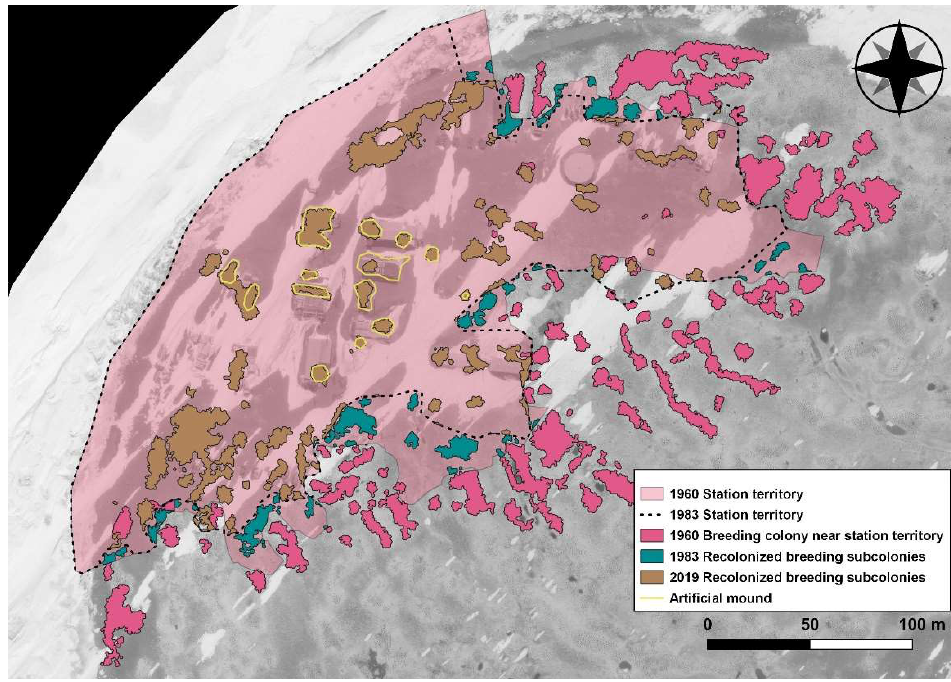
Figure 6. Spatial-temporal changes of nest distribution in penguin colonies at Cape Hallett.